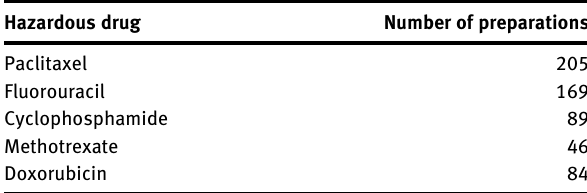
Table  : HD preparation